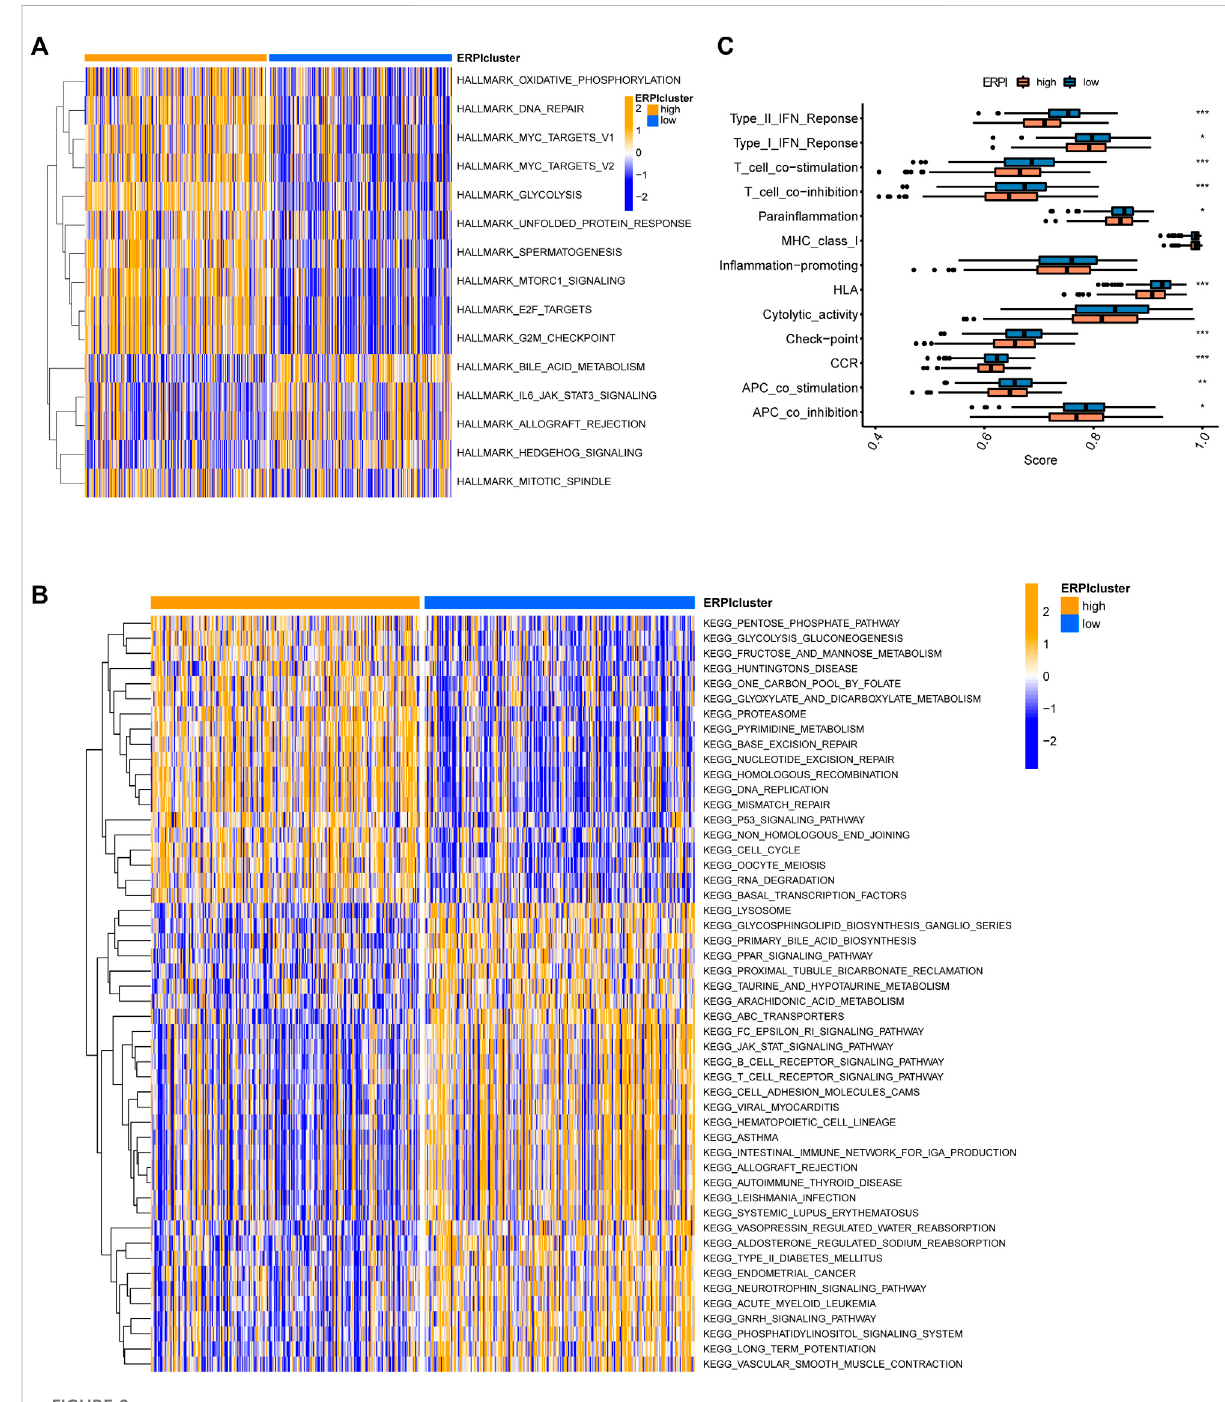
FIGURE 9 Functional annotation of the ERPI groups. (A) Differences in hallmarks between the high- and low-ERPI groups in GSVA. (B) Differences in pathwaysbetweenthehigh-andlow-ERPIgroupsinGSVA. (C)